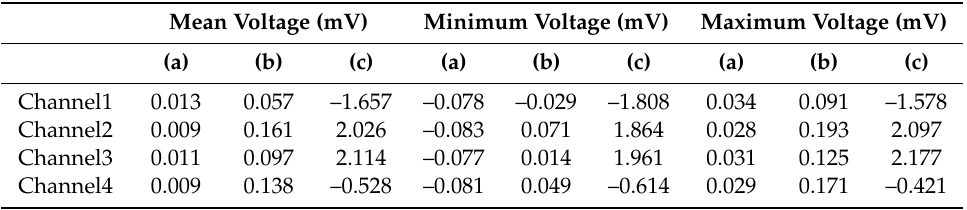
Table 1. The output voltage statistics of each channel with di ff erent